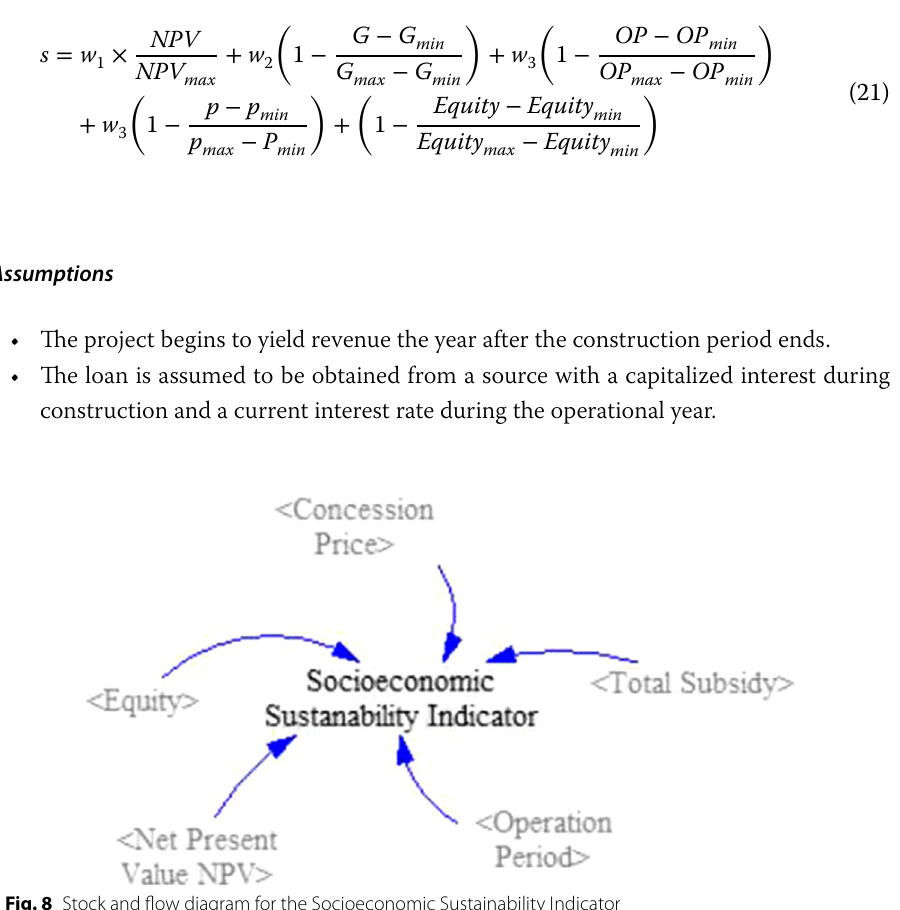
Fig. 8 Stock and flow diagram for the Socioeconomic Sustainability